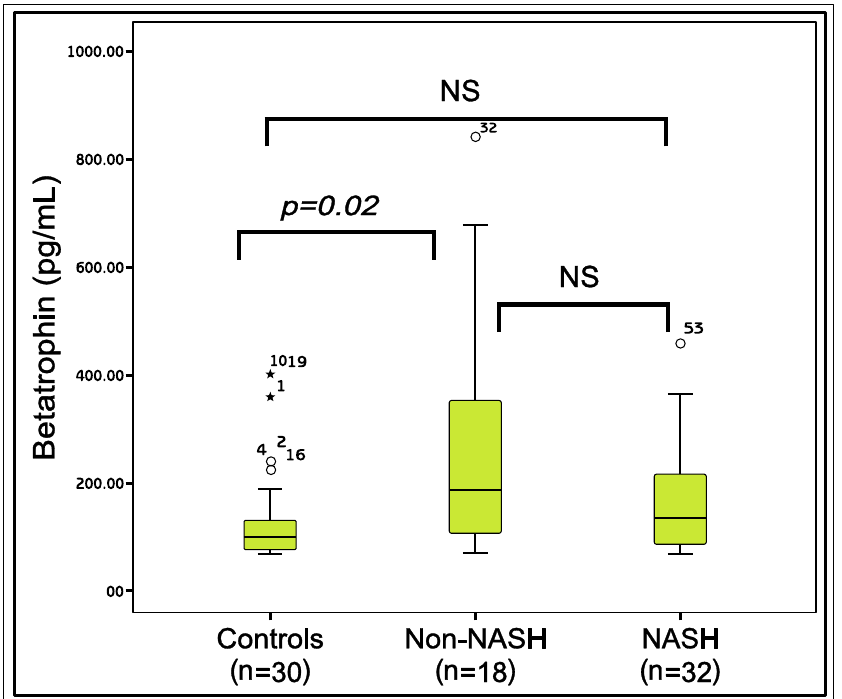
Figure 1. The comparison of the Betatrophin levels between the study groups. Mann-Whitney U test, p < 0.05 is significant; NS: Nonsignificant; *: The outliers.